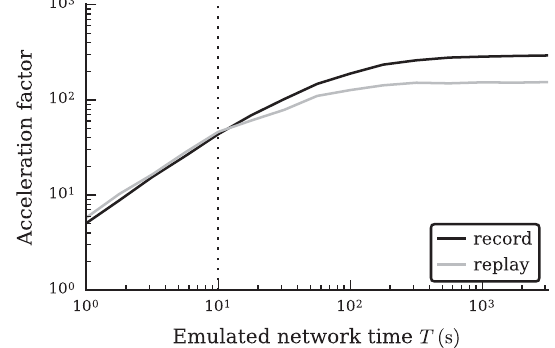
FIG. 10. Acceleration factor as a function of emulated network time T for the record (black line) and the replay cases (gray line). The acceleration factor is defined as the ratio between the emulated network time T (in biological time) and the execution time (wall clock time). In the record case, a network realization is generated on the host computer and uploaded to the chip. During the subsequent emulation, spike trains are recorded. In the replay case, spikes are replayed and the membrane potential of one neuron is recorded with full sampling frequency (9.6 kHz). The execution time covers the full data flow from a network description in PyNN to the emulation on the Spikey system and back to the network representation in PyNN. The time- averaged population firing rate is ¯ r ¼ ð 23 . 7 (cid:3) 0 . 2 Þ s − 1 . The vertical dashed line depicts the run time used in this study. The hardware system has to be initialized once before usage ( < 1 s), which is not considered